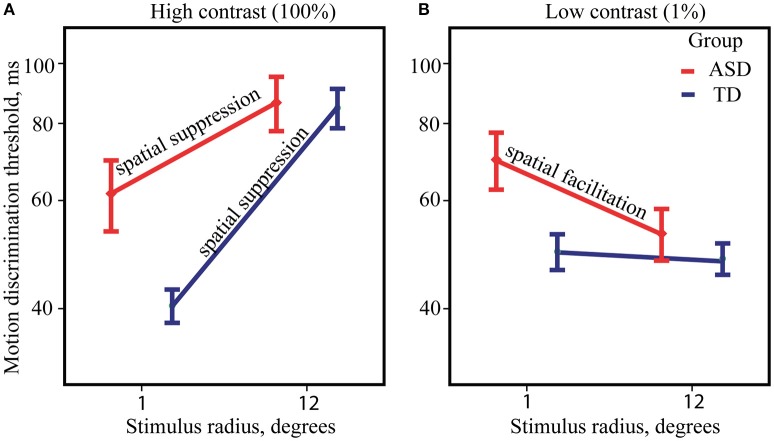
Size-dependent modulation of motion direction discrimination thresholds. The mean thresholds for ASD (red) and TD (blue) groups, obtained under high (A) and low-contrast conditions (B). Note that for demonstration purpose, threshold values are represented on y-axis in milliseconds along the log-transformed scale.